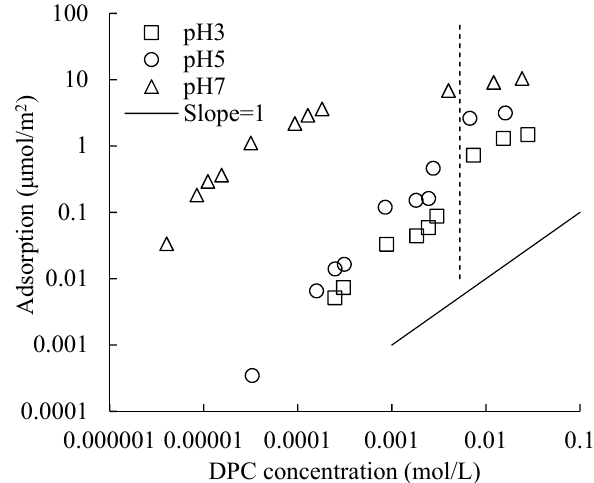
Figure 6. Isotherms of DPC adsorption on silica at 0.1 mol/L electrolyte concentration and different pHs. Dotted vertical line shows the CMC (Critical Micelle Concentration) of DPC at this electrolyte concentration.